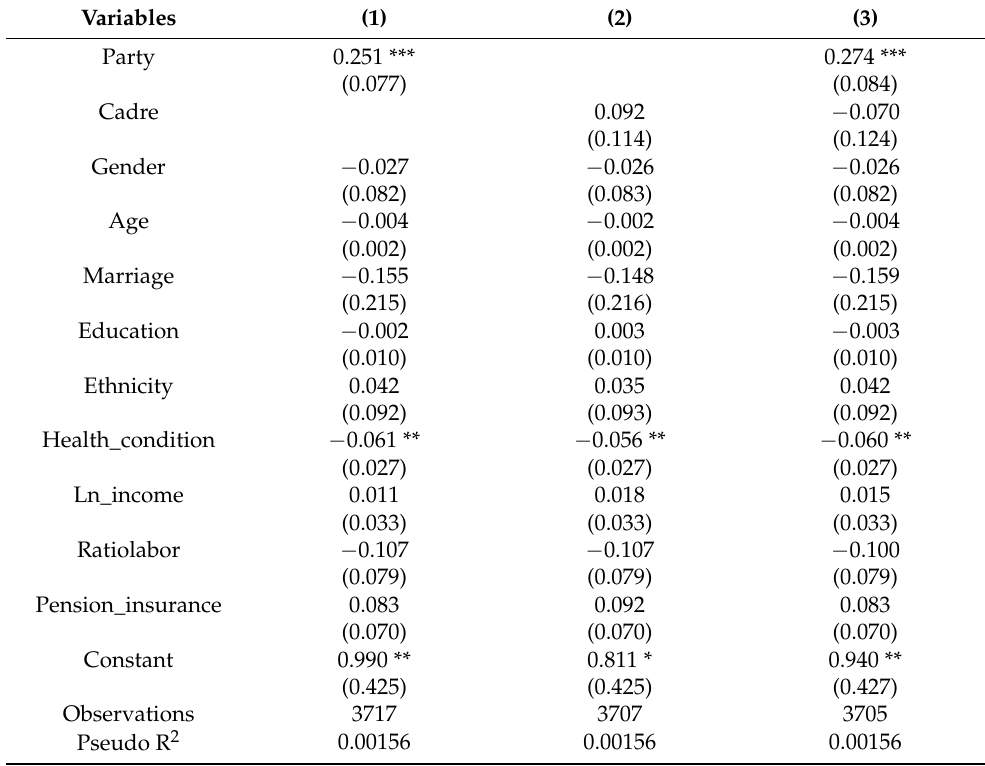
Table 3. Mechanism